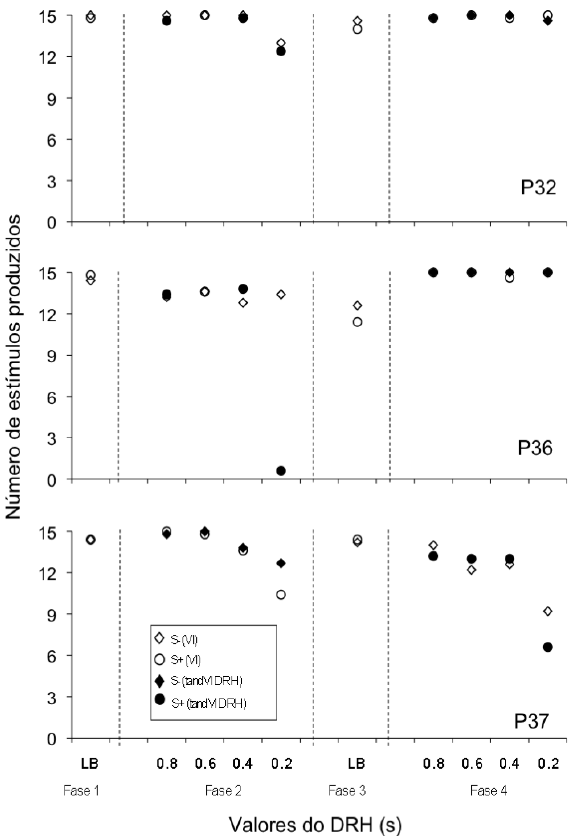
Figura 1 . Número médio de S + (círculos) e de S - (losangos) pro- duzidos nas cinco últimas sessões de todas as quatro fases experi- mentais, tanto em Linha de Base (símbolos vazados) quanto em cada uma das condições em que foram empregados diferentes va- lores do esquema tand VI DRH (símbolos cheios), para todos os